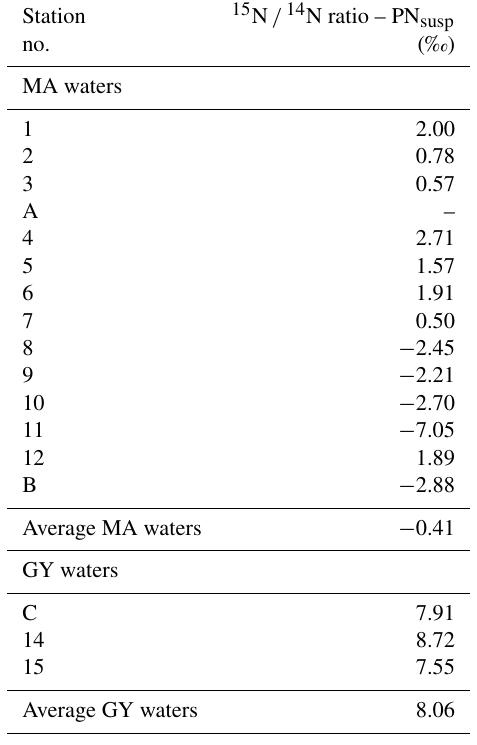
Table 1. 15 N / 14 N ratio of suspended particulate nitrogen (PN) (av- erage over the photic layer) across the OUTPACE